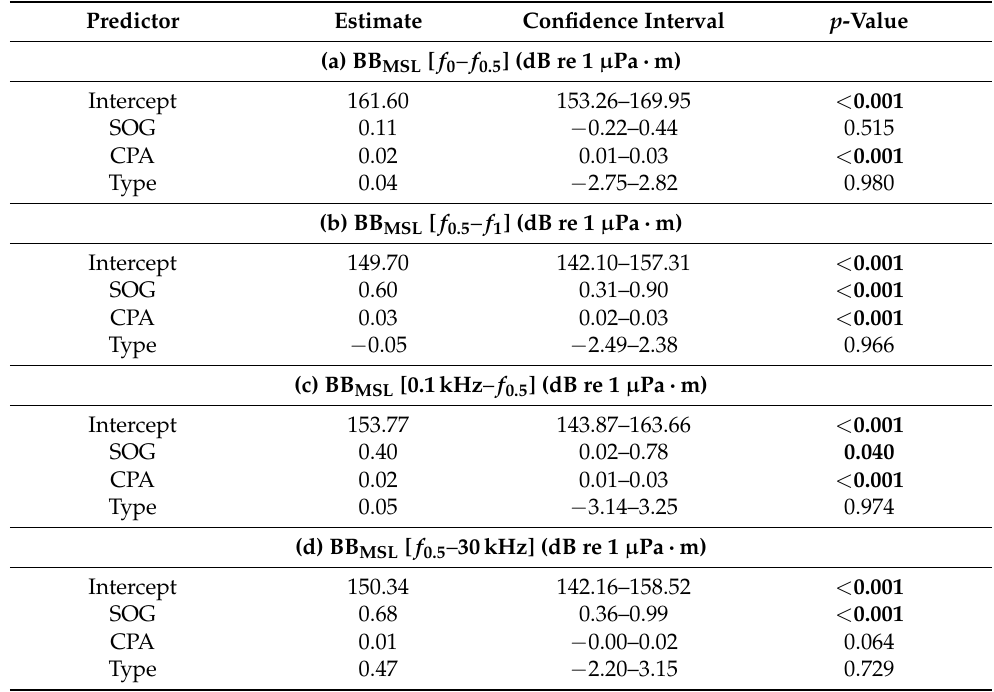
Table 3. Generalized Linear Mixed